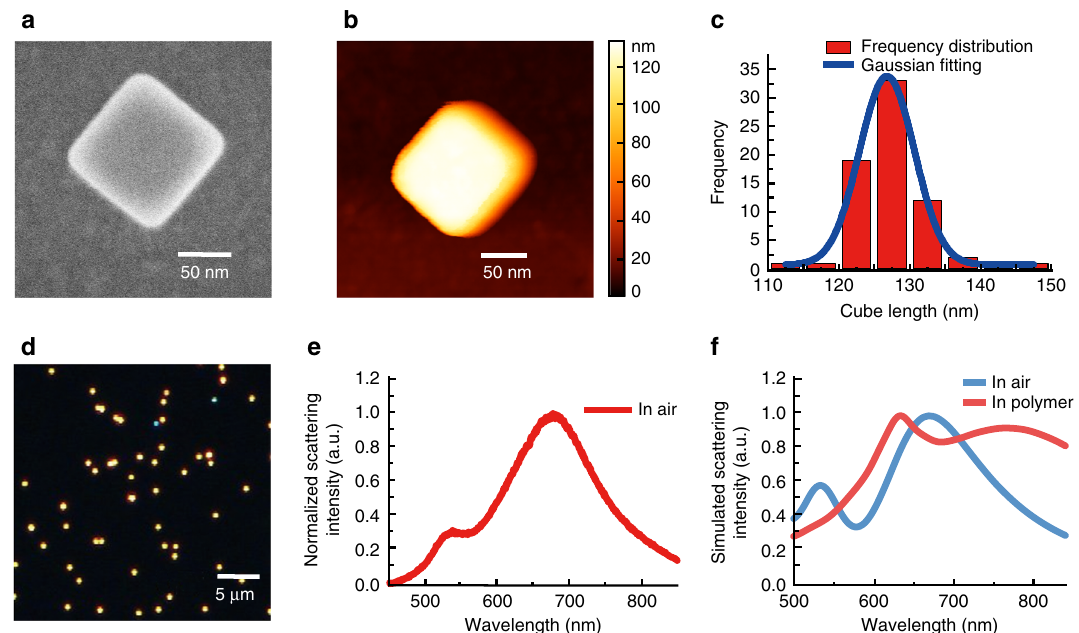
Fig. 1 Characterization of Au nanocubes. a SEM image, and b AFM image of a representative single Au nanocube (same object). c Nanocube size (edge length) histogram obtained from a set of 100 nanocubes (SEM analysis). d Dark- fi eld scattering image of Au nanocubes on ITO-coated glass substrate. e Dark- fi eld single-nanocube scattering spectrum averaged from 10 nanocubes in air on ITO-coated glass substrate. f Calculated scattering spectrum of a single Au nanocube in air and in polymer (refractive index n = 1.48) on ITO-coated glass substrate (40 nm thickness of ITO layer with refractive index of